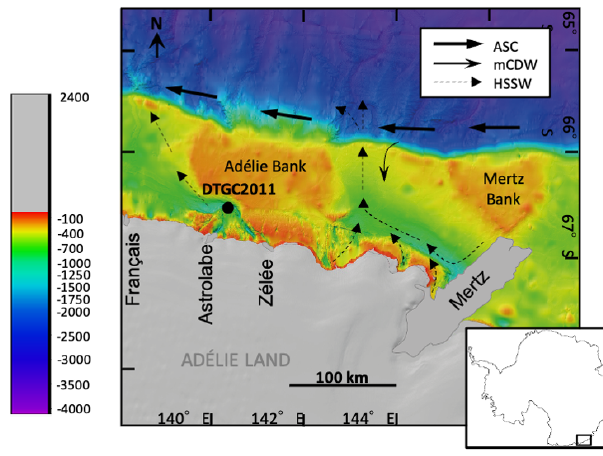
Figure 1. Location of Site DTGC2011 on bathymetric map of the Adélie Land region (modified from Beaman et al., 2011), indicat- ing positions of the main glaciers (prior to Mertz Glacier Tongue collapse in 2010) and pathways of the main water masses affect- ing the region: Antarctic Slope Current (ASC), Modified Circum- polar Deep Water (mCDW) and High-Salinity Shelf Water (HSSW) (Williams and Bindoff,